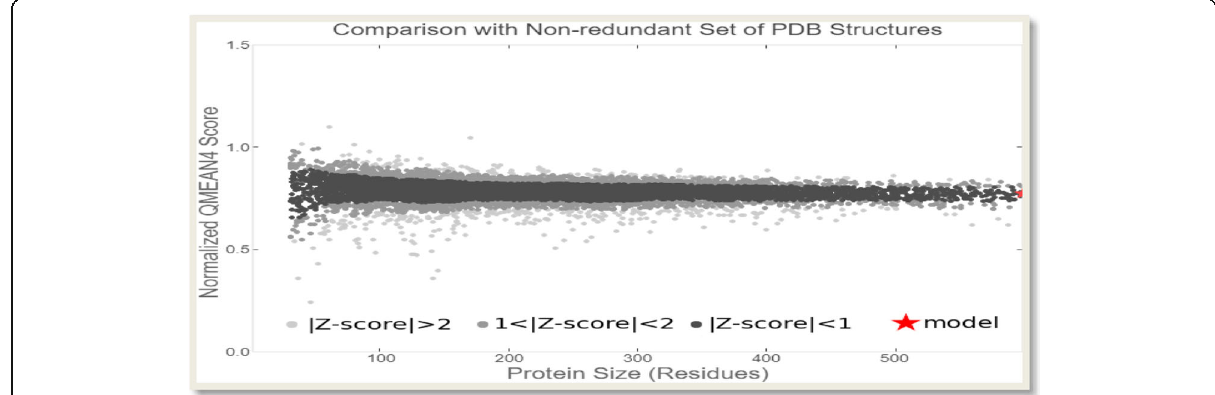
Fig. 7 Graphical presentation of estimation of absolute quality of the target